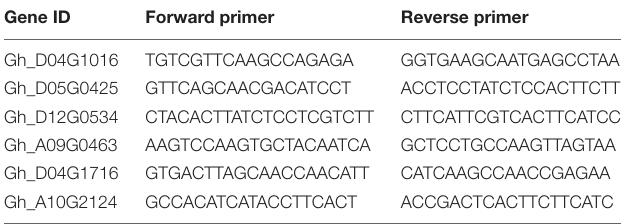
TABLE 1 | Primers of qRT-PCR for candidate